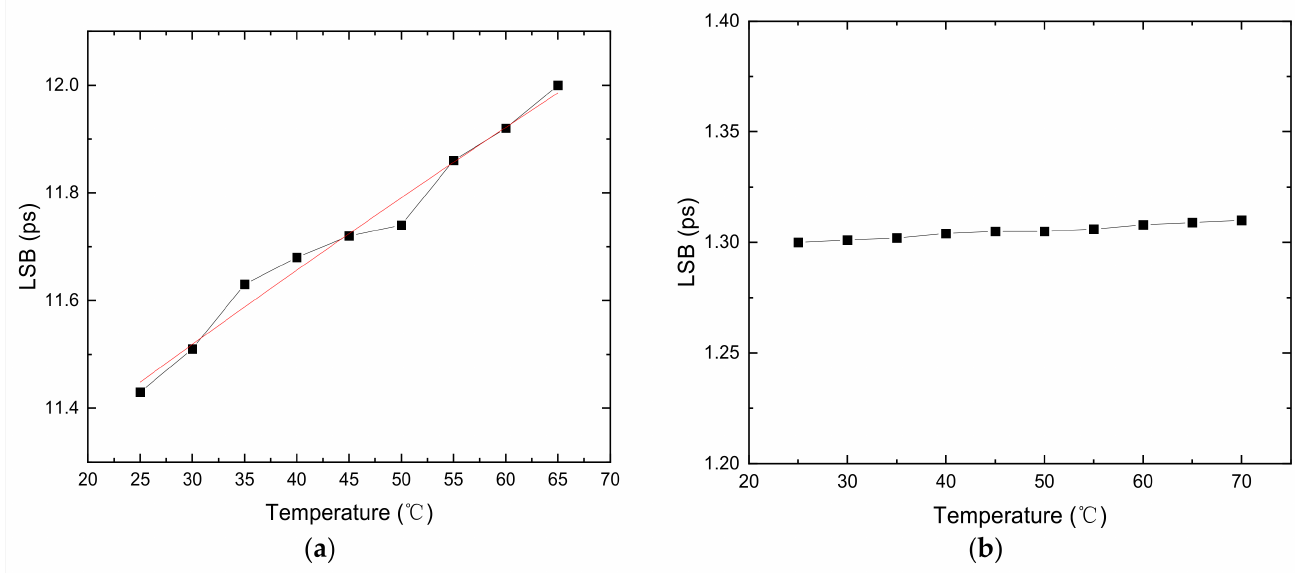
Figure 13. LSB of the TDC with different chain number varying with ambient temperature. ( a ) Chain number = 1; ( b ) chain number =